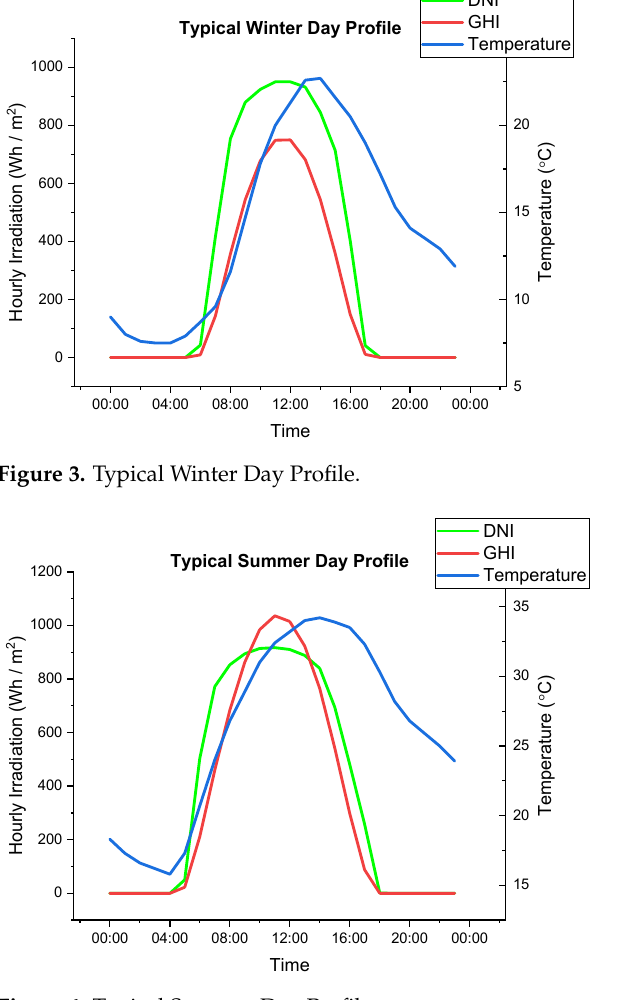
Figure 4. Typical Summer Day Profile 256 Figures 3 and 4 showing typical weather profiles in winter and summer, respectively.